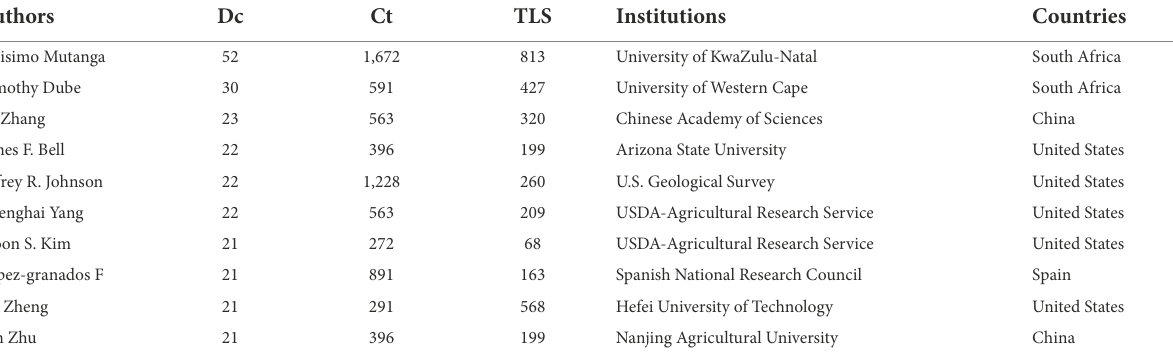
TABLE 3 Top 10 authors ranked by total literature on agricultural multispectral research in